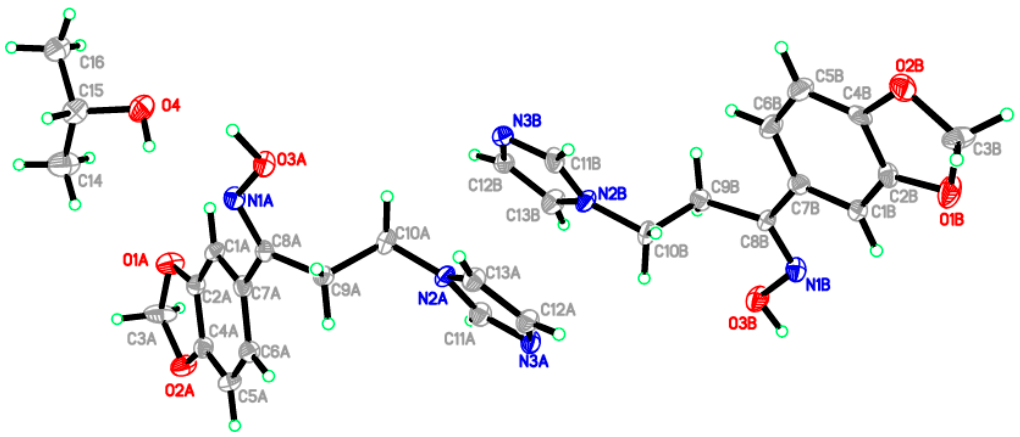
Figure 1. ORTEP diagram of the title compound drawn at 40% ellipsoids for non-hydrogen atoms showing two molecules and one isopropanol molecule as a solvent.